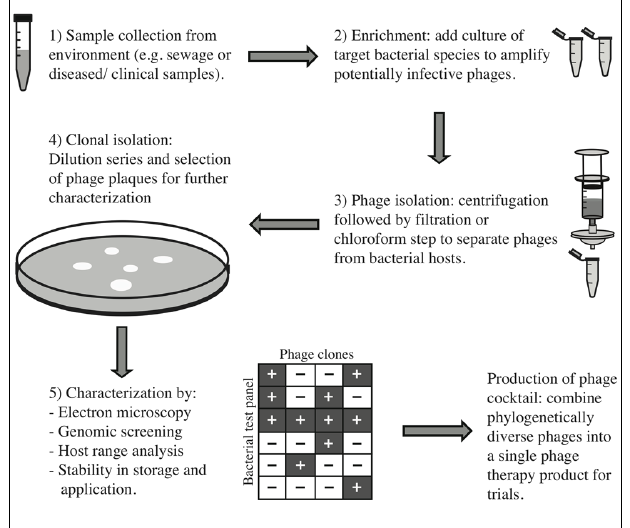
FIGURE 1 |Typical production of phage